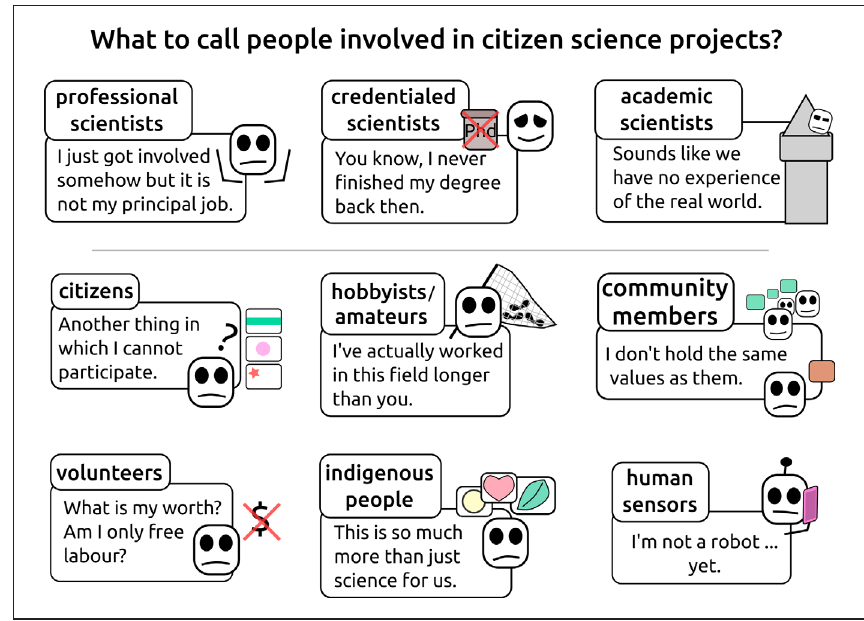
Figure 1: Illustrated examples of negative interpretations of commonly used names to describe people participating in citizen science, selected from our list of terms. Every term is used and interpreted in many different ways in different situations; this graphic highlights interpretations commonly encountered by the authors (also see Tables 3 and 4, particularly ‘caveat’